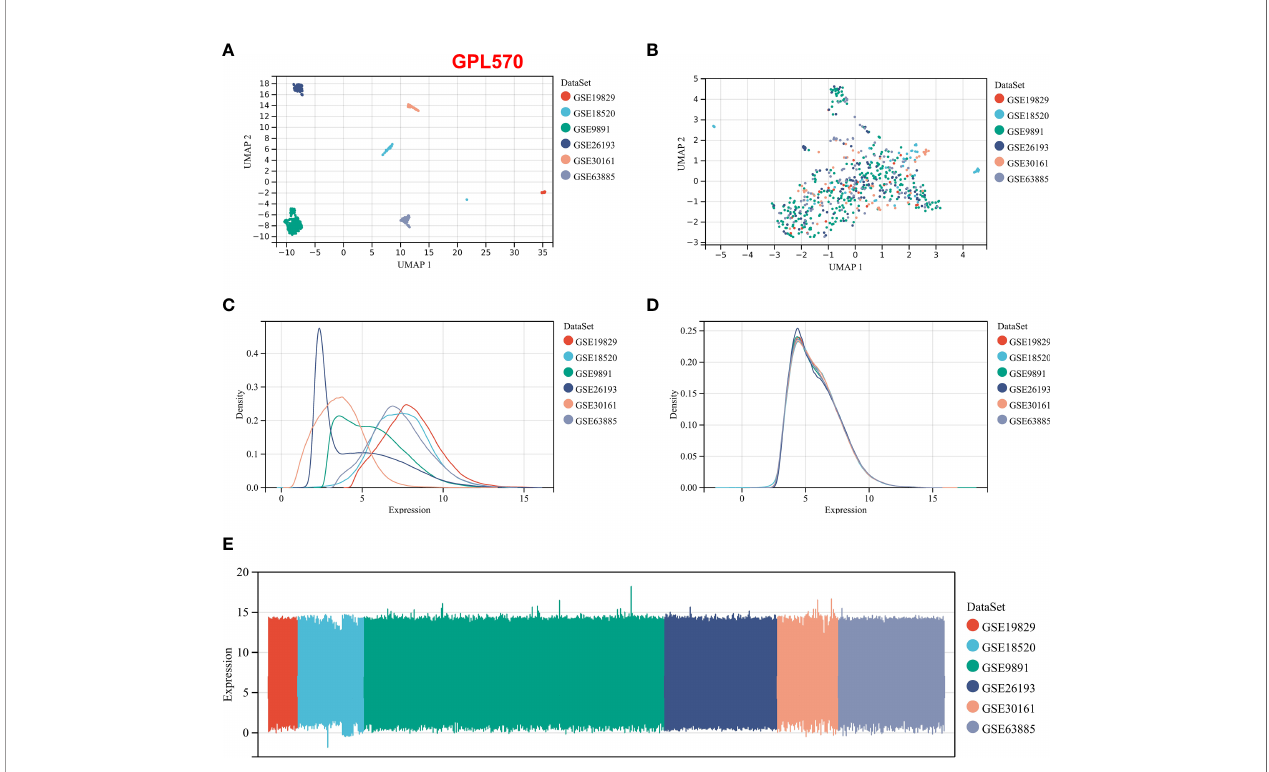
FIGURE 1 | Normalization process based on the GPL570 platform dataset. (A) UMAP plot of the six datasets before normalization. (B) UMAP plot of the six datasets after normalization. (C) Expression density plot of the six datasets before normalization. (D) Expression density plot of the six datasets after normalization. (E) Expression distribution plots for the six datasets after normalization. UMAP, Uniform Manifold Approximation and